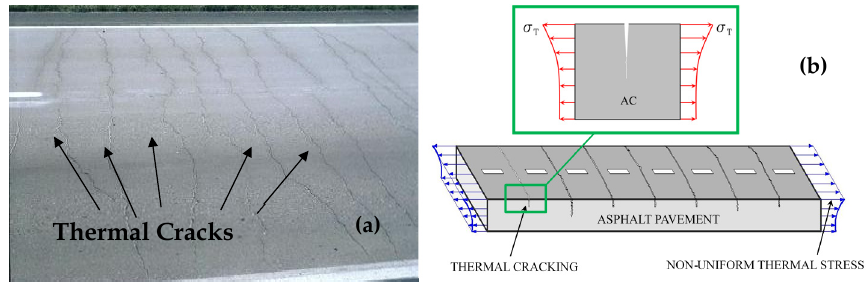
Figure 1. Thermal cracks as a result of oxidation; ( a ) typical thermal cracking pattern in asphalt pavement, ( b ) thermal cracking formation and non ‐ uniform distribution of thermal stresses through the pavement thickness.